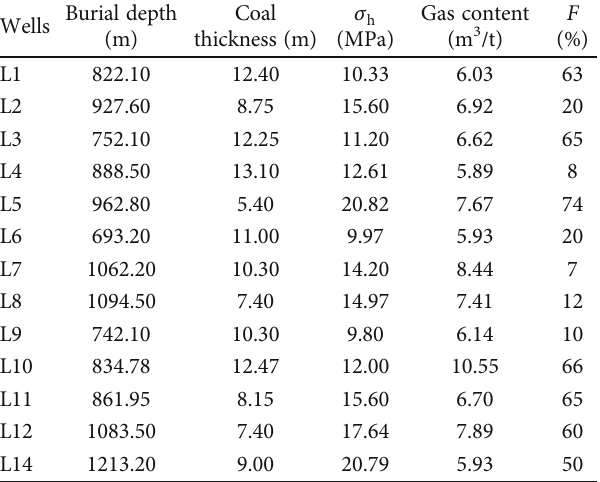
Table 1: Coal burial depth, thickness, minimum horizontal principal stress, gas content, and coal body structure index of No. ( 8 + 9 ) coal seam in Yangjiapo